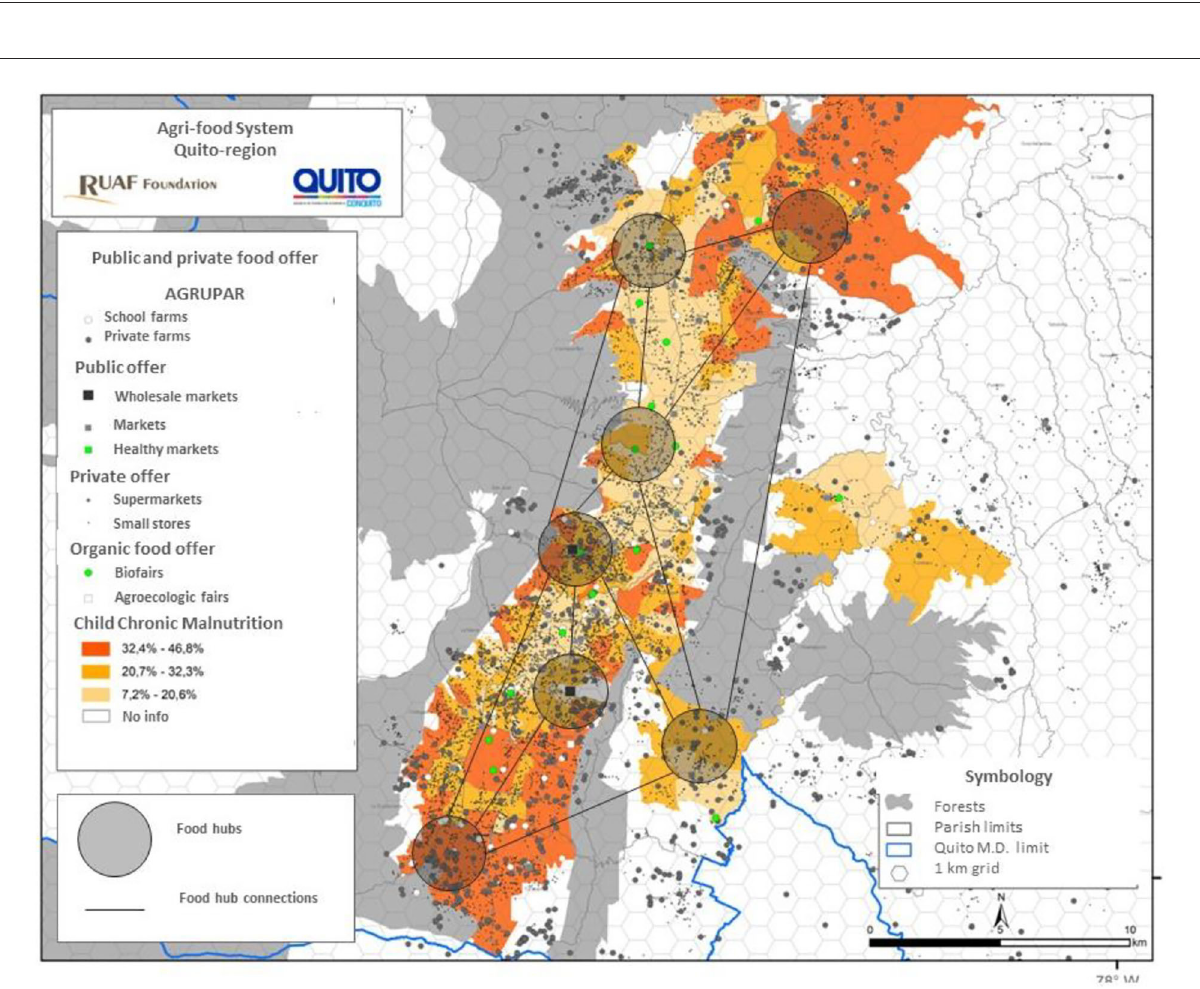
FIGURE2 Map showing a representation on how food hubs can be understood. Source: Quito’s metropolitan information system, AGRUPAR, Ministry of Health